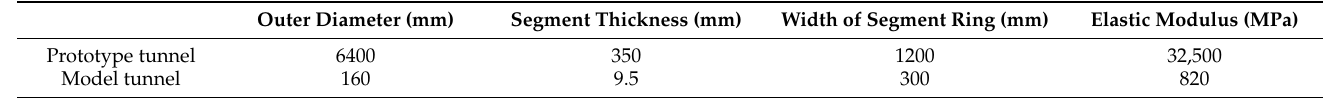
Table 1. Parameters of the prototype tunnel and model tunnel.